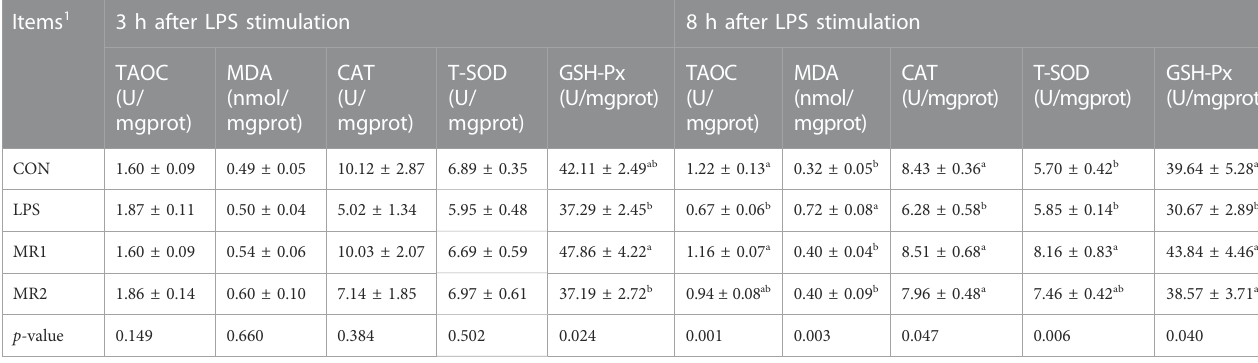
TABLE 6 Effects of dietary methionine restriction on liver antioxidant capacity of LPS-stimulated broilers (n = 6). Items